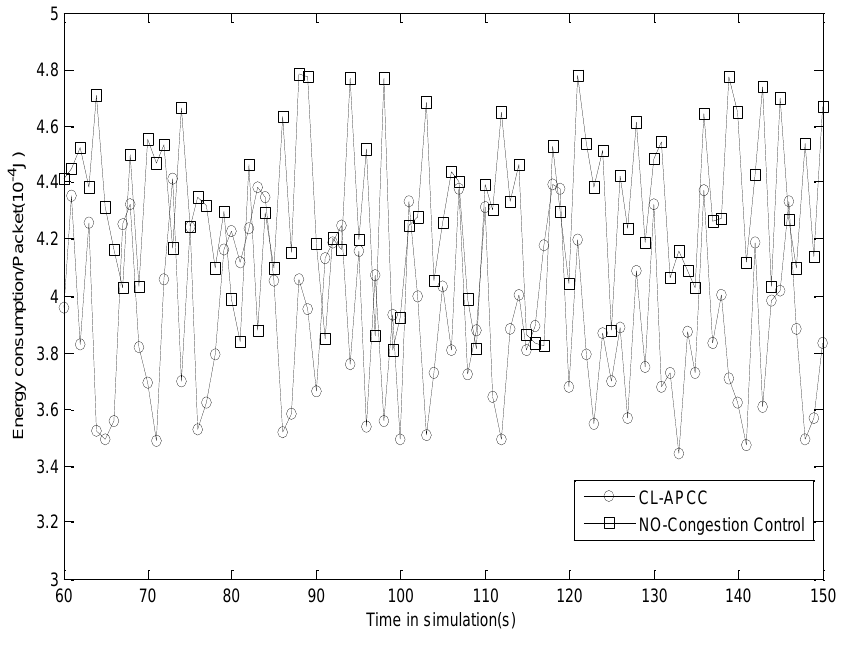
Figure 13. The average energy consumption of each data packets received by